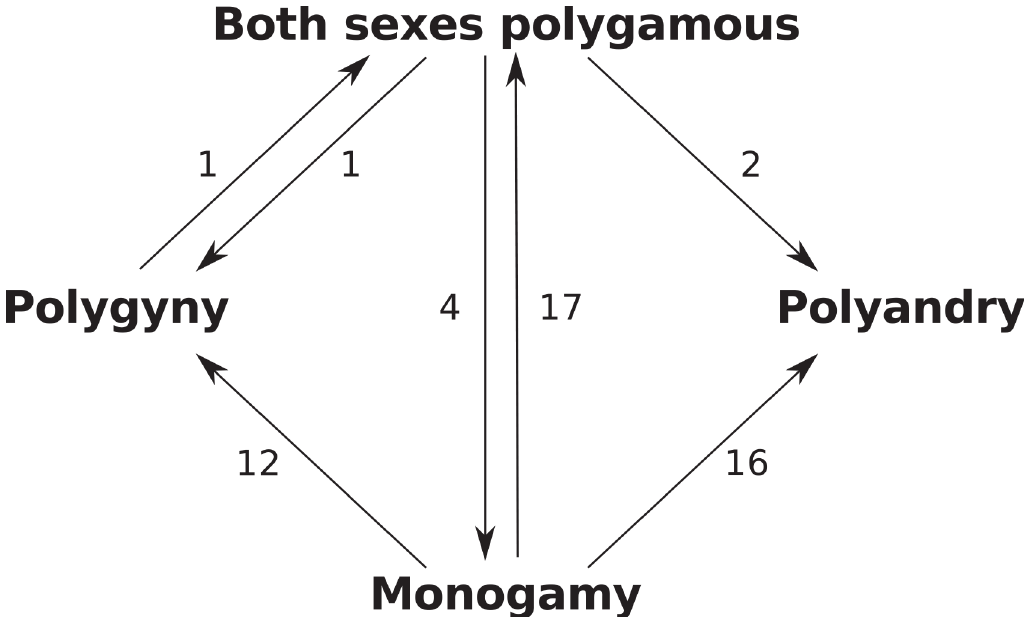
Fig 6. Most likely number of transitions between different polygamy character